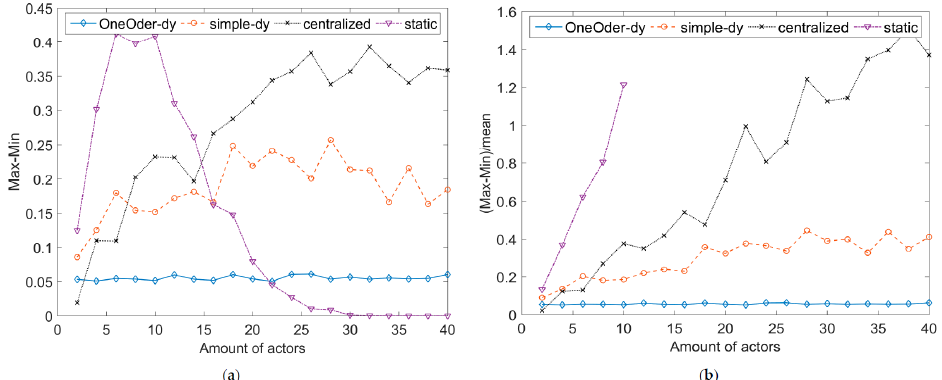
Figure 18. The Mean, Max and Min reliability of four strategies against the complexity of decision, (for centralized decision process, we set p mg = p 1 ).